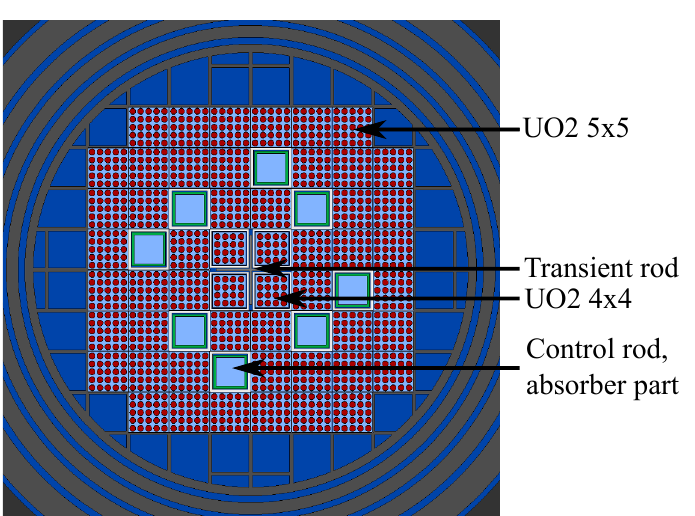
Figure 1: Horizontal view of the Serpent reference model of the SPERT III E-core with the fuel assembly types UO2 5x5 and UO2 4x4 , the transient rod, and the control rods.